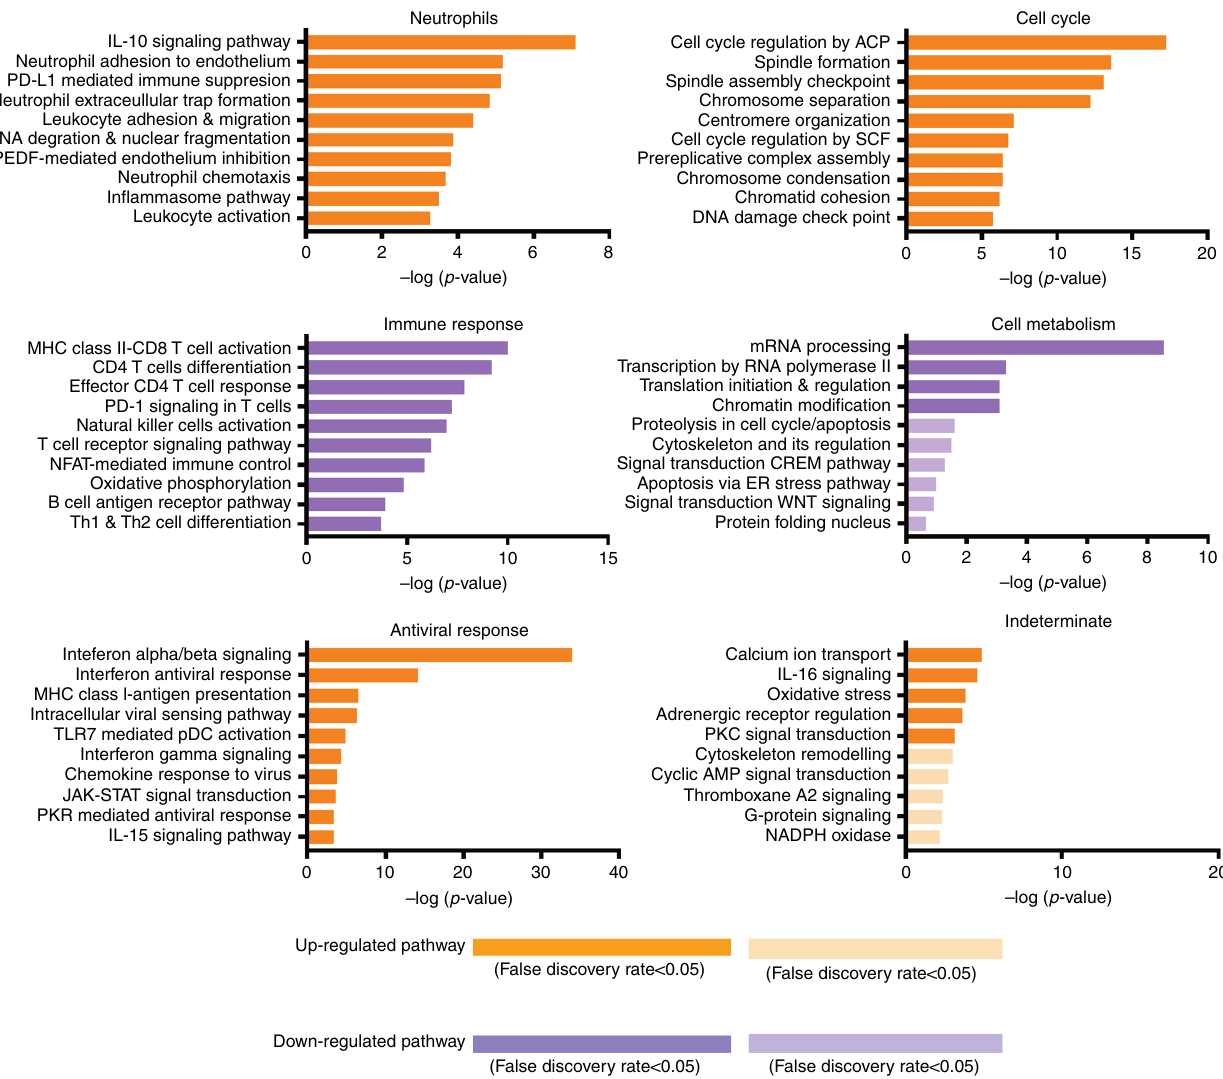
Fig. 6 Pathway analysis. Top ten pathways ranked by p values (horizontal bars) in six main modules. Horizontal axis denotes statistical signi fi cance as measured by minus logarithm of p values. False discovery rate greater than 0.05 is indicated by faded horizontal bars. Detailed statistics of the pathway analysis are also given in Supplementary Fig. 6. The source data are available in Gene Expression Omnibus (GSE